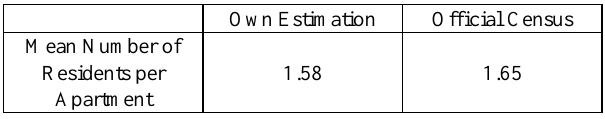
Table 3. Validation via the mean number of residents per